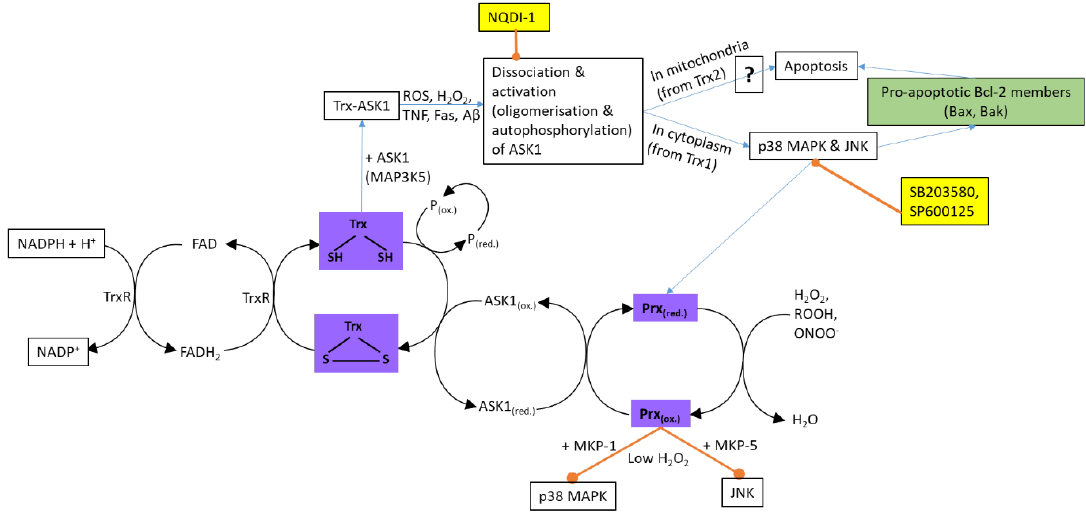
Figure 2. A simplified diagram of the regulation of ASK1-mediated apoptosis by thioredoxin (Trx) and peroxiredoxin (Prx). A β (amyloid β ); ASK1 (apoptosis signal-regulating kinase 1); FAD (flavin adenine dinucleotide); Fas (apoptotic receptor); JNK (c-Jun NH 2 -terminal kinases); MKP (MAPK phosphatases); NADP (nicotinamide adenine dinucleotide phosphate); P (protein); TNF (tumour necrosis factor α ); ROS (reactive oxygen species); TrxR (thioredoxin reductase); ? (means that this pathway is still unexplored); 🠢 (activation); ⟜ (inhibition). Compounds in yellow boxes are